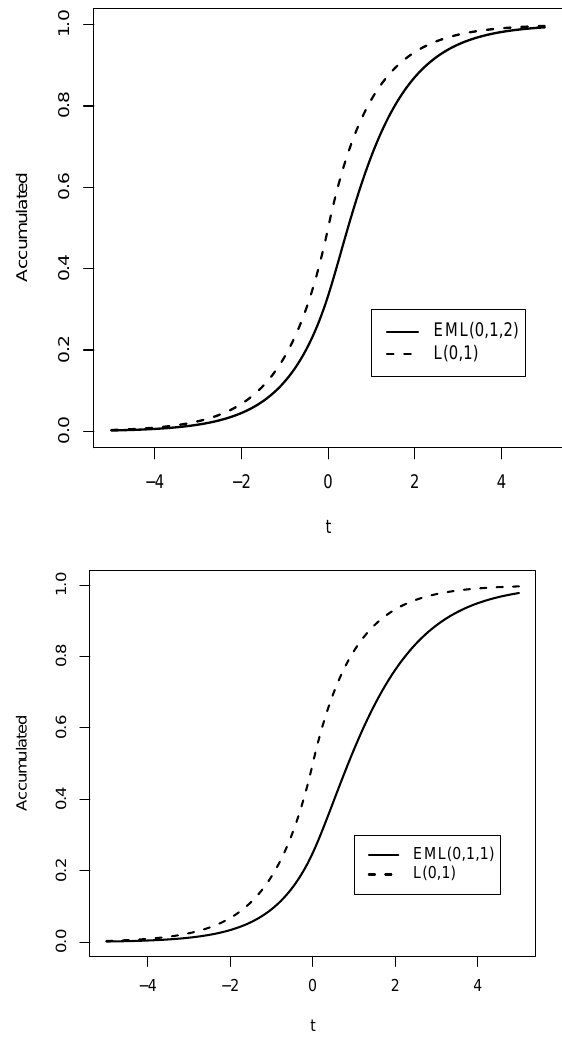
Figure 2. Comparison of the cdf of the EML distribution (solid line) for λ = 2 ( upper ) and λ = 1 ( lower ) with the cdf of the distribution L (dashed line).